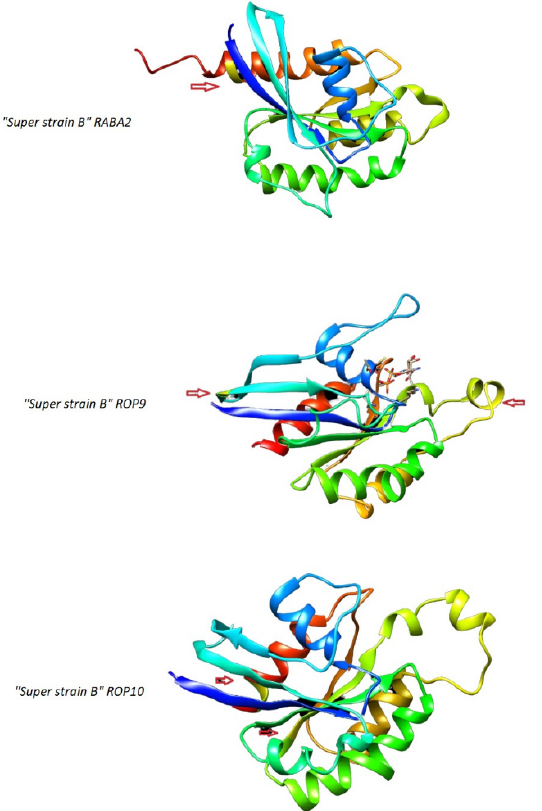
Figure 5. Three-dimensional models of RABA2, ROP9, and ROP10 from Solanum lycopersicum “Super strain B”. Arrows and yellow boxes indicate the position of the substitutions noticed in super strain B versus other legume and non-legume species.